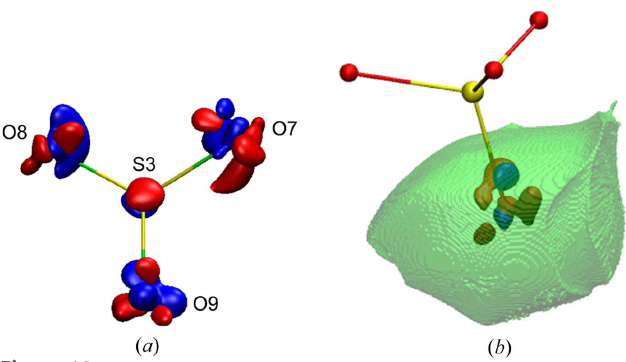
Figure 13 Difference of total electron density at the ( a ) SO 4 group, difference between ambient pressure and 1 GPa (iso-contour: + 0.005 blue and (cid:4) 0.005 red). ( b ) Map of the difference between ambient pressure and 10 GPa (iso-contour: +0.05 and (cid:4) 0.05; blue and red,